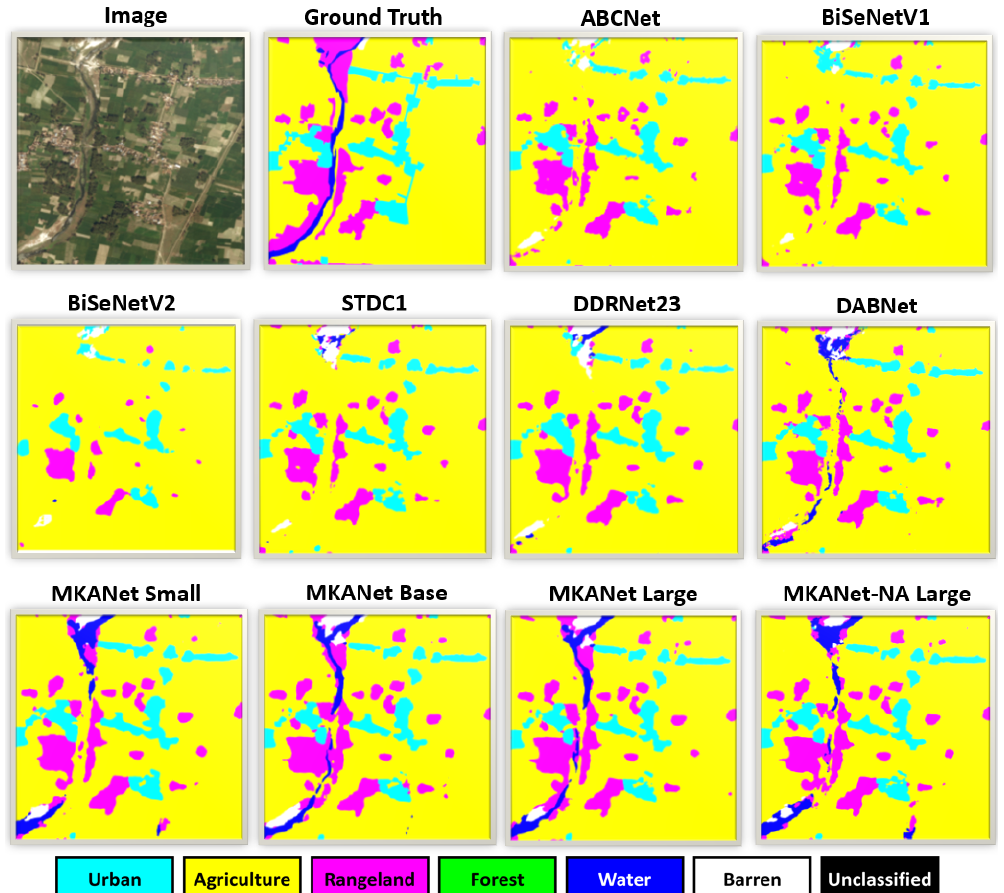
Figure 11. Comparison of the masks predicted by different methods on the DeepGlobe Land Cover